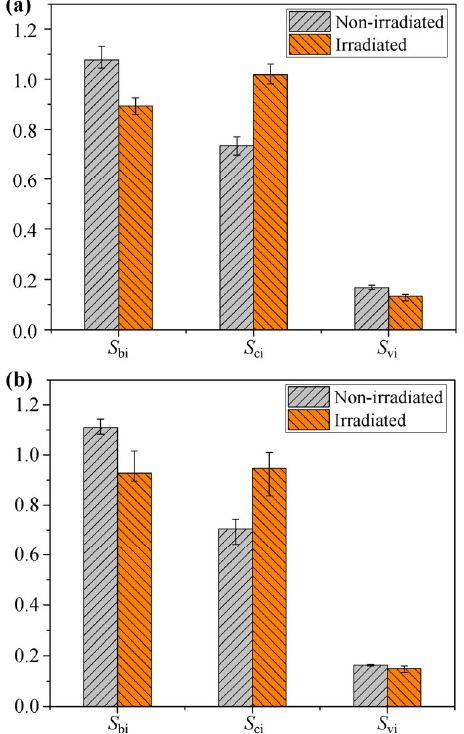
Fig. 5 Surface functional parameters of non-irradiated and irradiated cemented surfaces, (a) YN6; (b) YN10.